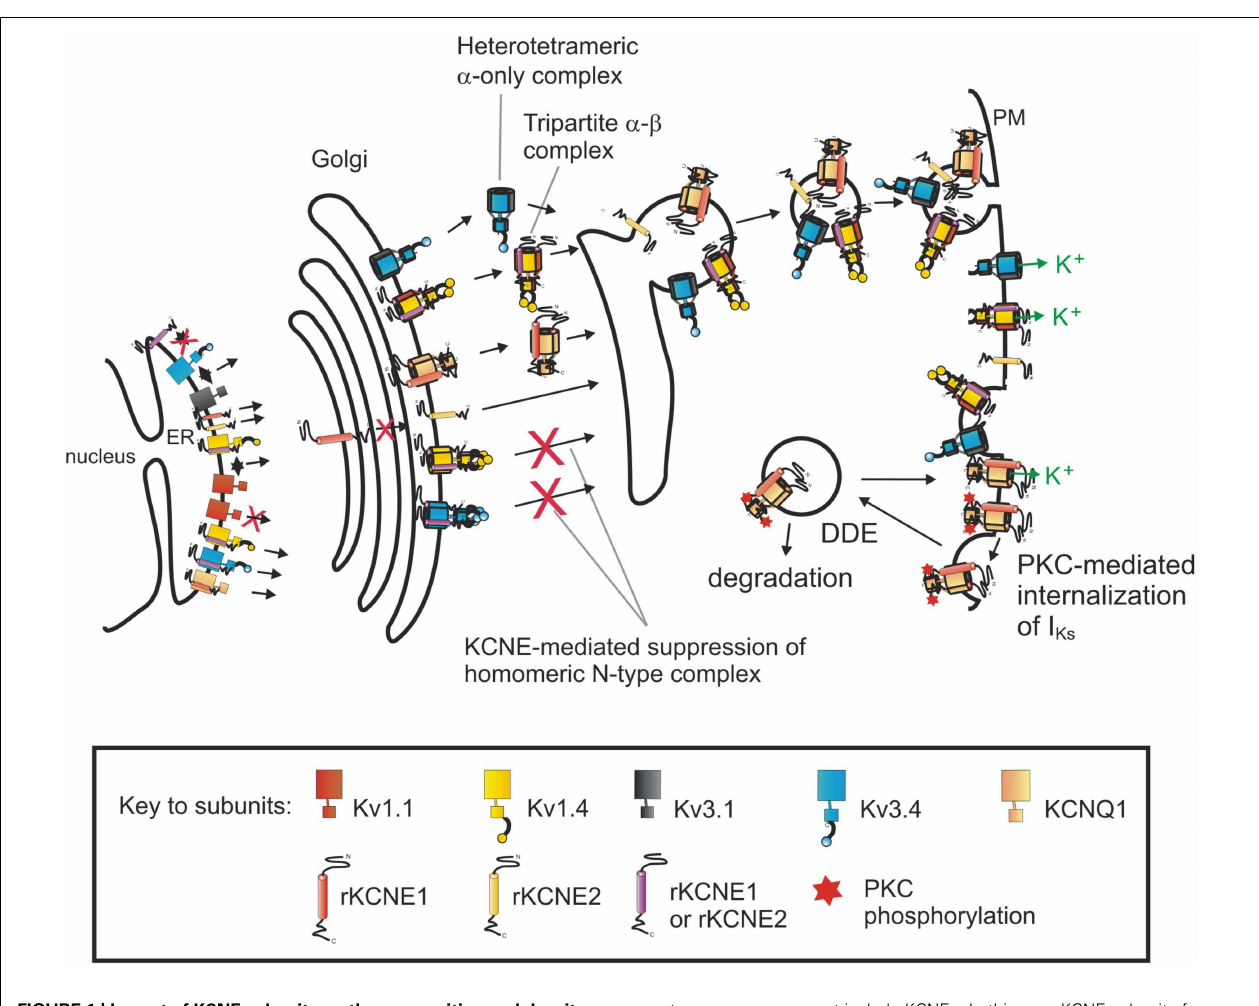
FIGURE 1 | Impact of KCNE subunits on the composition and density of surface-expressed Kv channels. Pore-forming Kv α subunits, as listed in the key, form complexes in the ER that are trafficked through the Golgi to the plasma membrane (PM). KCNE1 and KCNE2 prevent the surface expression of homomeric N-type Kv channel complexes, but ensure heteromeric (mixed- α ) complexes, that depending on their α subunit